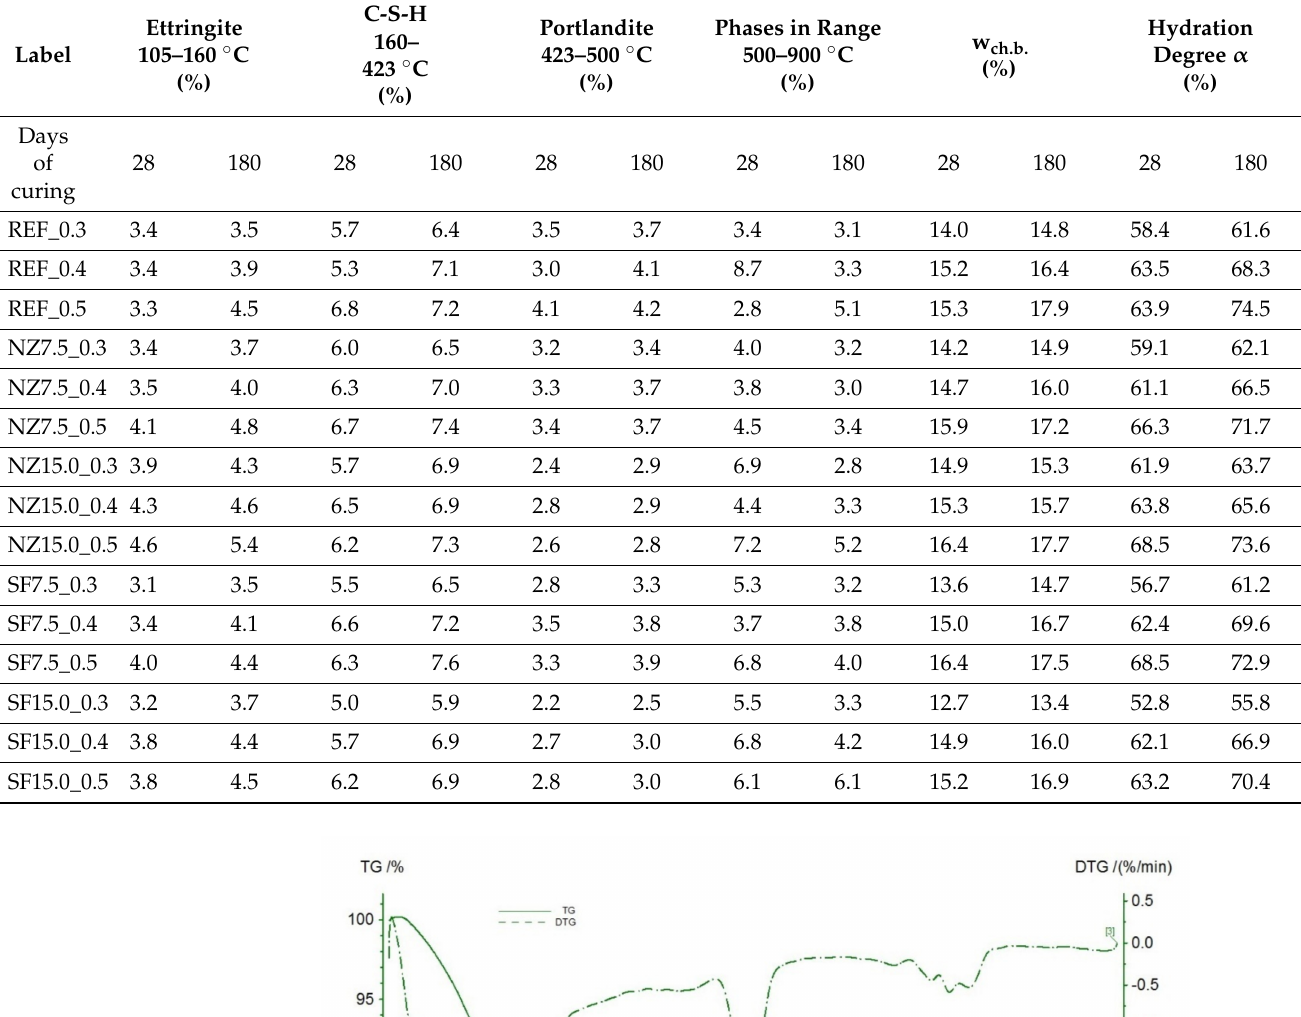
Table 6. Mass loss measured by thermal analysis (TA) in regards to the main hydration products, chemically bounded water, and hydration degree.